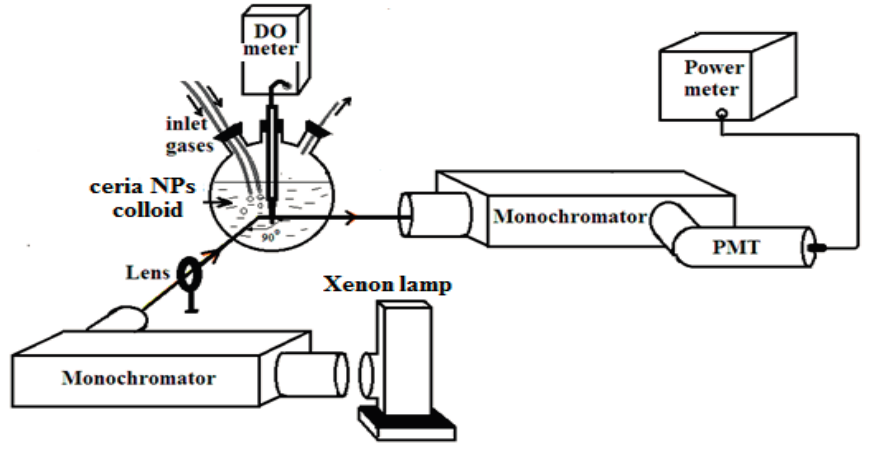
Figure 1. Experimental setup of optical sensing for dissolved